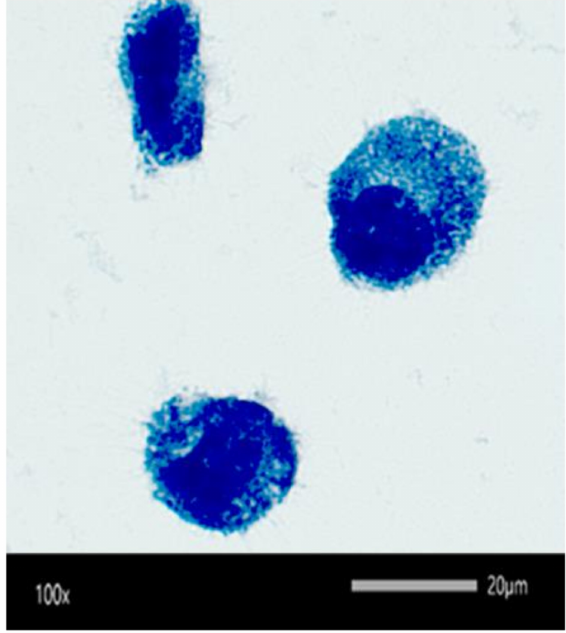
Figure 6. The intracellular presence of small colony variants (SCV) S. aureus (stained dark blue) as observed under the light microscope using Leishman’s